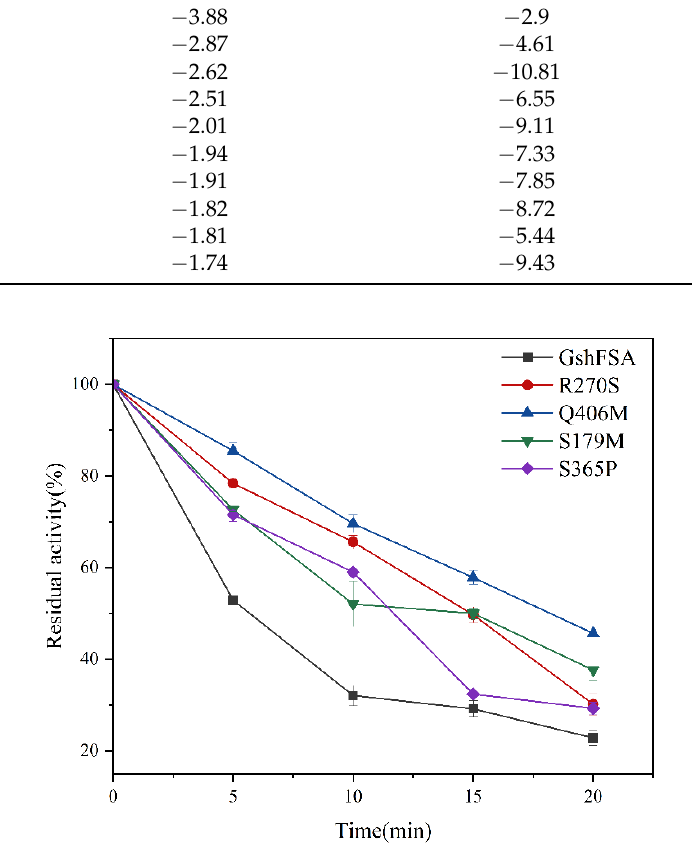
Figure 4. Thermal deactivation at 40°C of wild type and mutants.